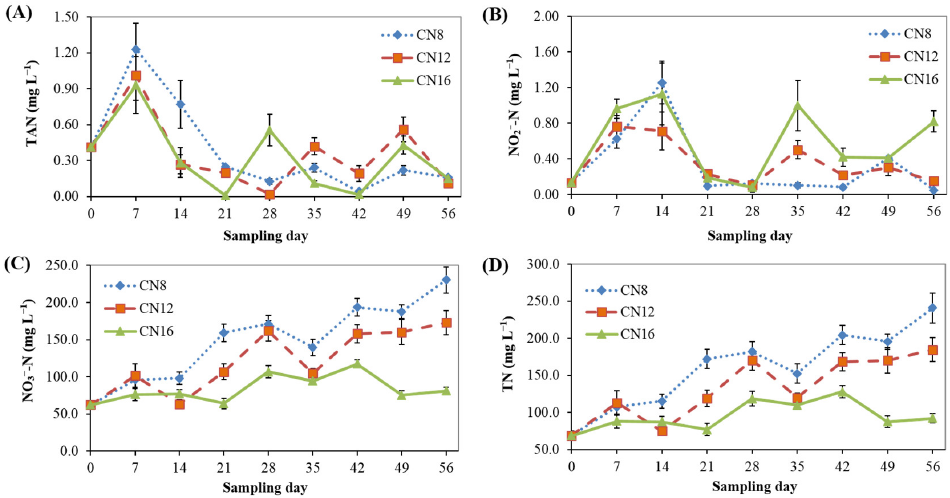
Figure 2. Nitrogen dynamics in the culture water of biofloc-based tank systems during an 8-week intensive production trial of P. vannamei with three input C/N ratios (means ± S.D., n = 3): ( A ) TAN, total ammonia nitrogen; ( B ) NO 2 − -N, nitrite nitrogen; ( C ) NO 3 − -N, nitrate nitrogen; ( D ) TN, total